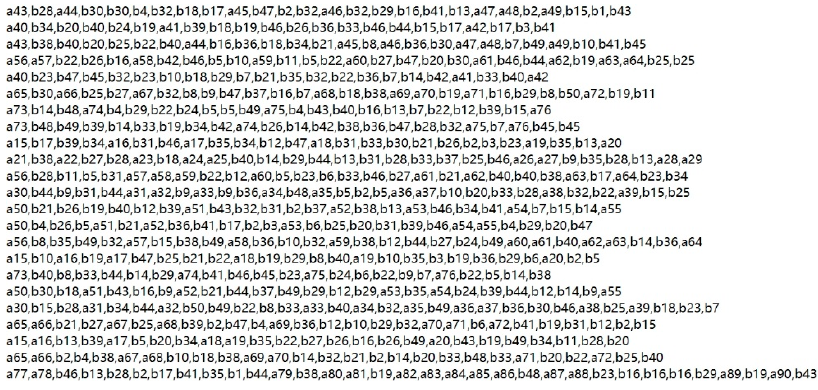
Figure 4. The generated noisy sessions.